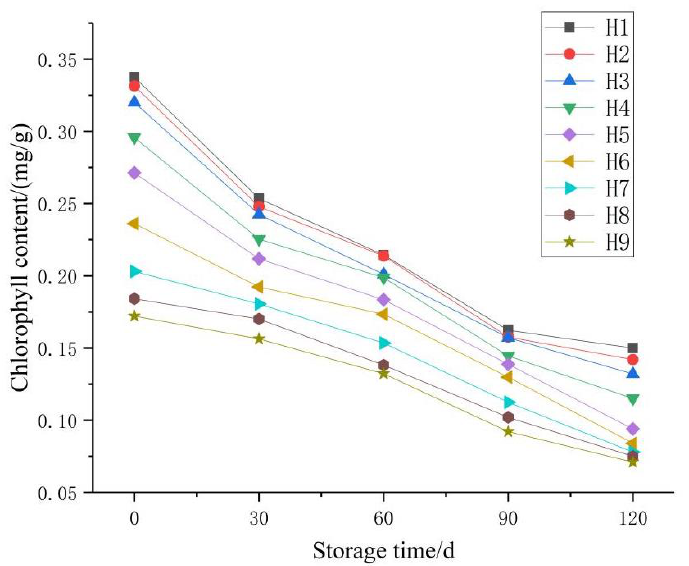
Figure 2. Variation laws of chlorophyll content in the pericarp during the storage period. Note: H1 – H9 represent the harvest periods of the fragrant